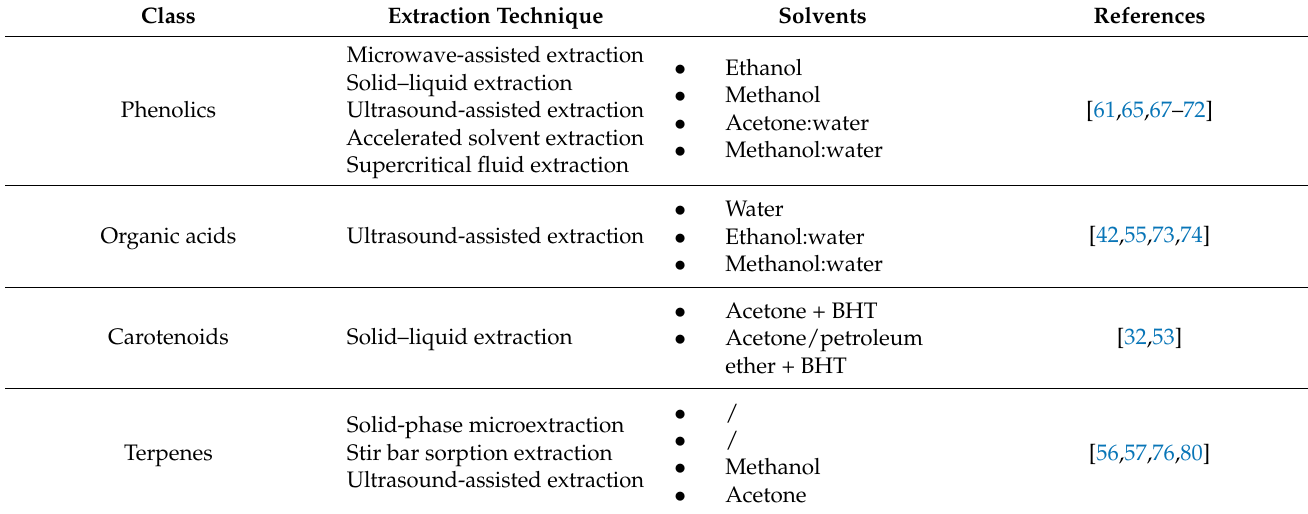
Table 3. Overview of the methods used for the extraction of the main phytochemical classes occurring in apples.